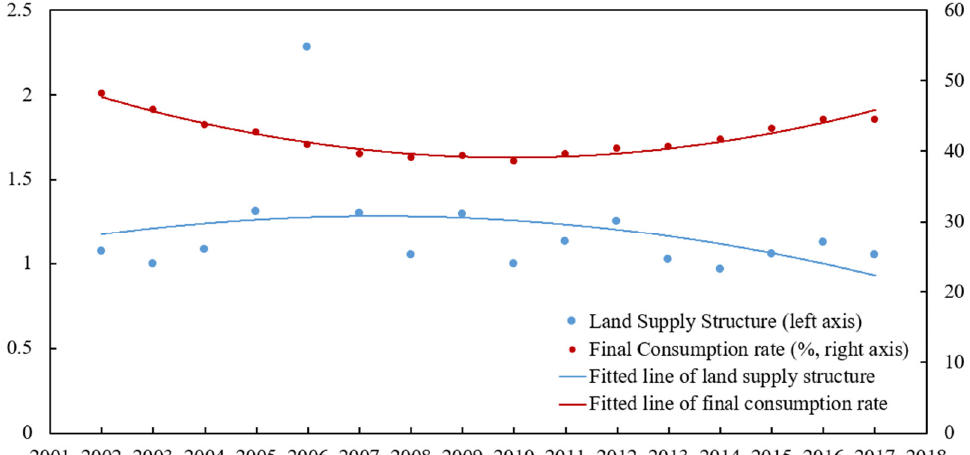
Figure 2. The ratio of industrial land area to commercial and residential land area and final consump- tion rate (%), 2002–2017. Sources: The National Bureau of Statistics and the “China Land Resources Statistical Yearbook ” .